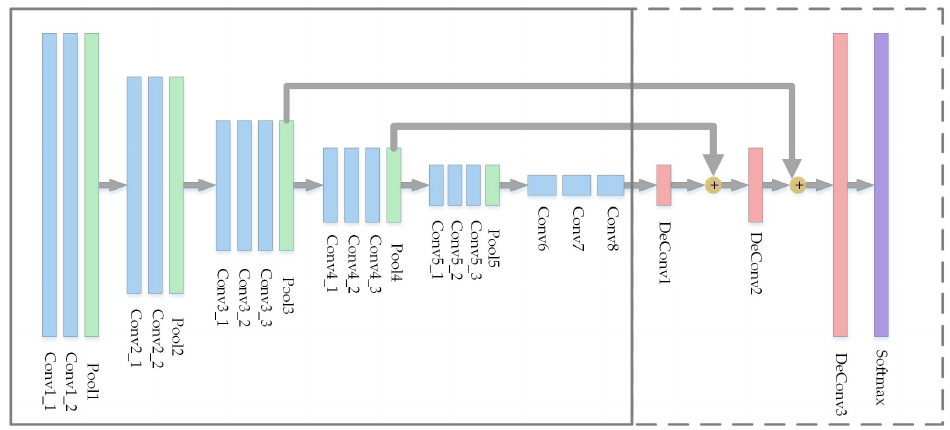
Figure A1. Architecture of FCN-8s, where structure depicted in the solid-line box is encoder and structure depicted in the dashed-line box is decoder.